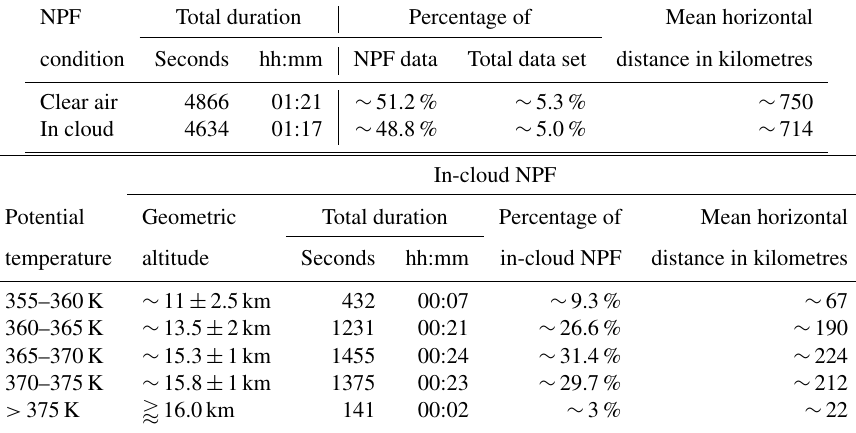
Table 1. NPF data set of StratoClim 2017, separated by event detection under clear-air (i.e. N ice = 0cm − 3 ) and in-cloud conditions (i.e. N ice > 0cm − 3 ). Discussed in-cloud NPF events (104 incidents that comply with introduced NPF criterion; Sect. 2.2) are partially embedded in larger clear-air NPF fields with continuously elevated N nm . The total number of measurement seconds with NPF detections under either of both conditions is scaled to the total data set of the condensation nuclei (CN) measurements and the total duration of NPF encounters. The mean horizontal distance is calculated from the event duration based on a mean flight speed of the M-55 Geophysica (154 ± 39ms − 1 ), providing an equivalent horizontal extension of NPF. Geometric heights are interpolated values with maximum range of scattering from UCSE data of the eight flights. NPF Total